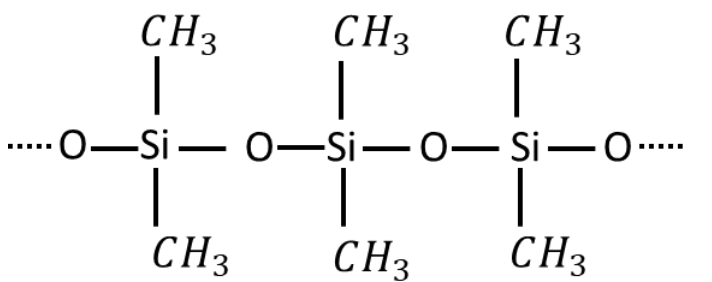
Figure 2. Basic molecular structure of PDMS.